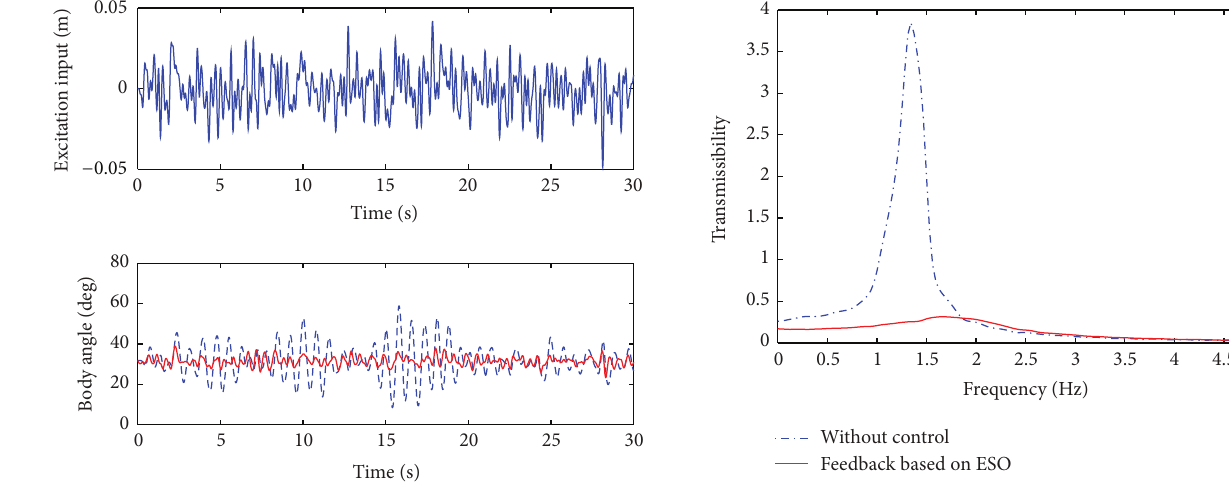
Figure 7: Transmissibility of excitement input (mm) to body angle output (degree) of